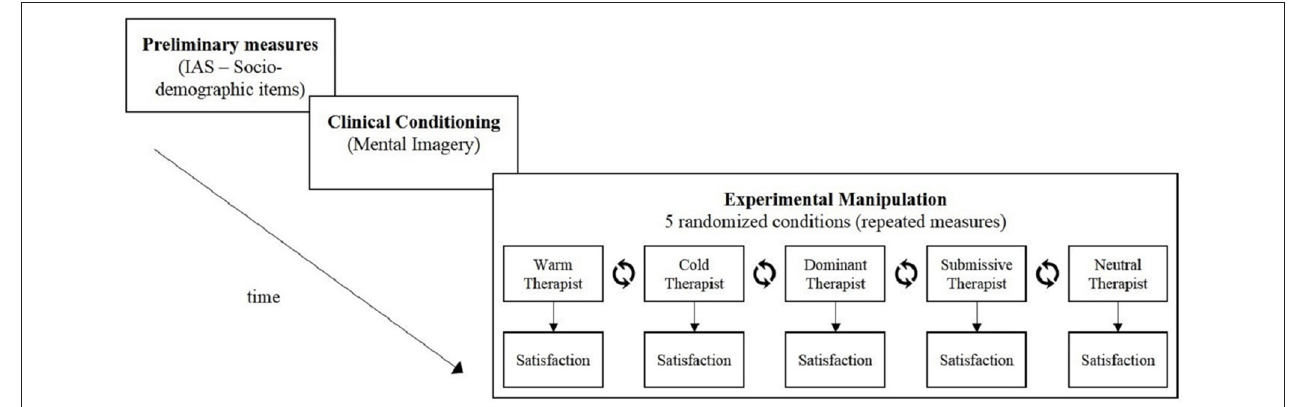
FIGURE 2 | Time-line of the experimental procedure. Presentation of three main steps of the experimental procedure. Each participant had to follow these steps and was confronted to the five experimental conditions manipulating the therapist’s interpersonal profile.